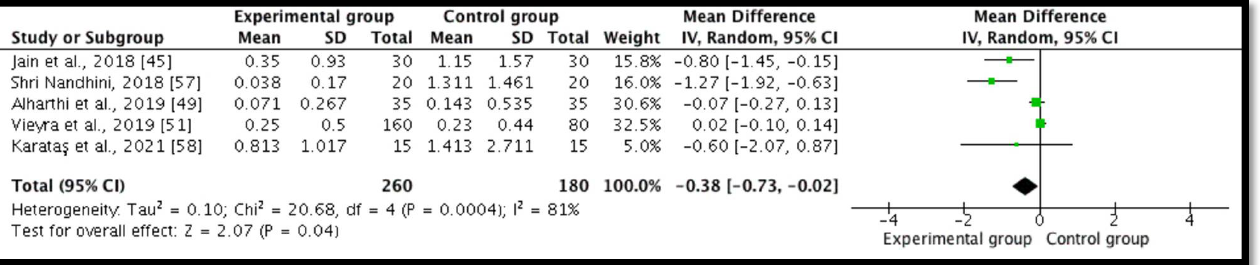
Figure 4. Forest plot comparing postoperative pain between the experimental group (intracanal cryotherapy) and the control group (room temperature) at 24 h.